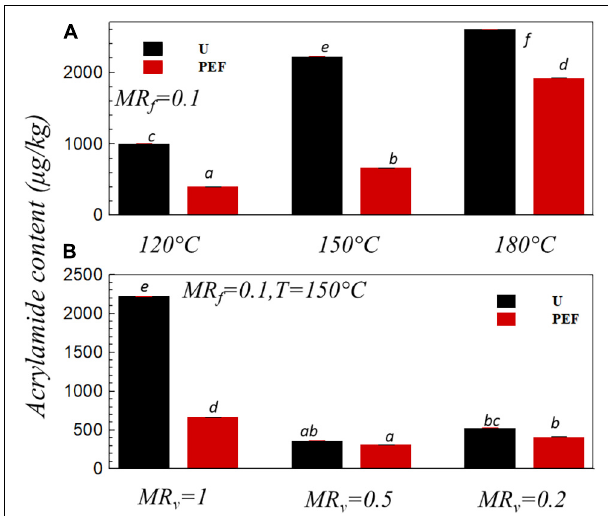
FIGURE 6 | Acrylamide content vs. the frying temperature (A) and vs. the moisture ratio after VD , MR v (B) for U and PEF pre-treated samples. All samples were fried to MR f = 0.1( p <